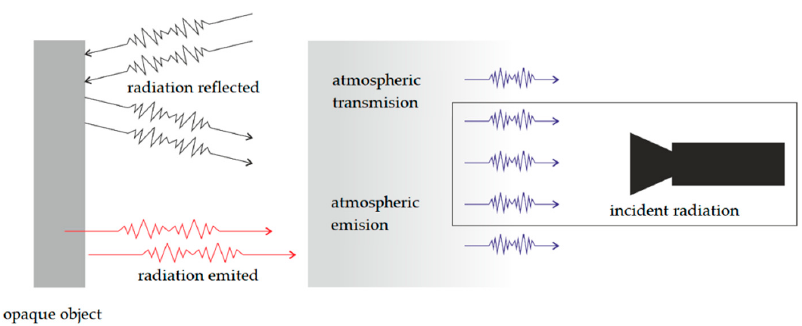
Figure 4. Components of incident InfraRed (IR) radiation acquired by the thermographic camera.